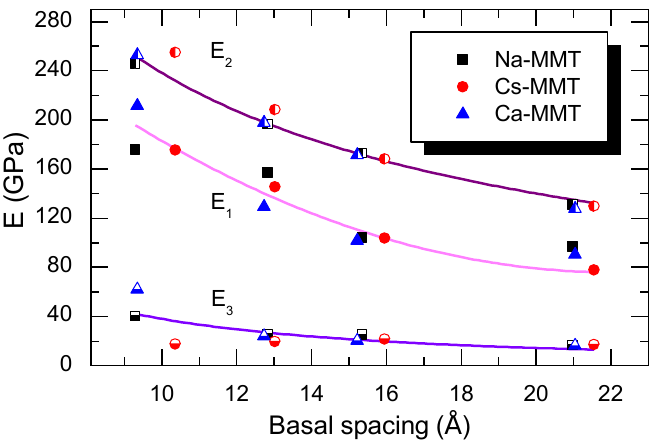
Figure 10. Young modulus as a function of basal layer spacing.